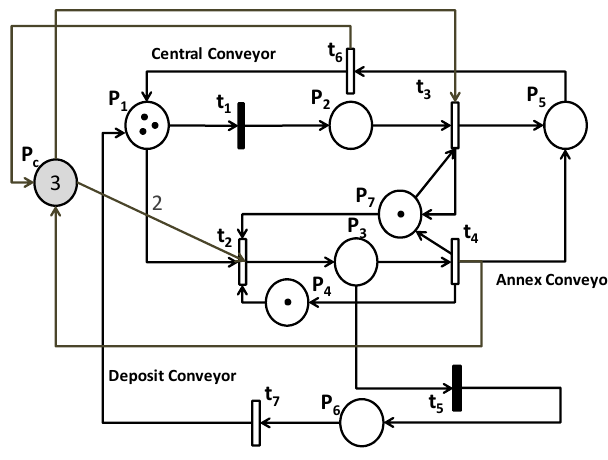
Figure 9. The controlled PN 3. Table 10. Forbidden markings (P 5 P 6 ) of Example 3.